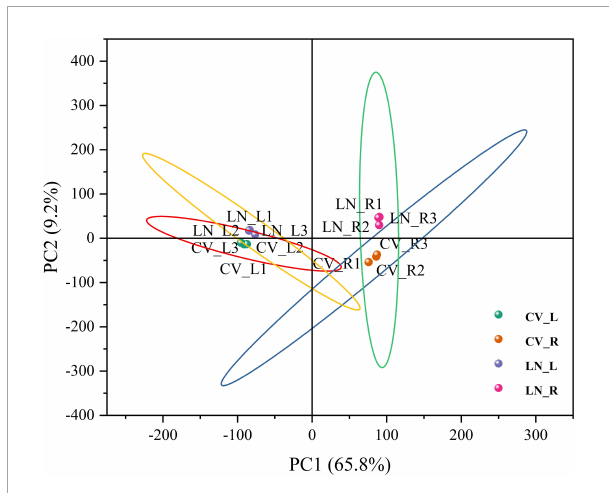
FIGURE 1 PCA plot of transcriptomes under low N stress in sugar beet. CV_R, control group, root; CV_L, control group, leaf; LN_R, low N group, root; LN_L, low N group, leaf; PCA, principal component analysis. The same abbreviations are used